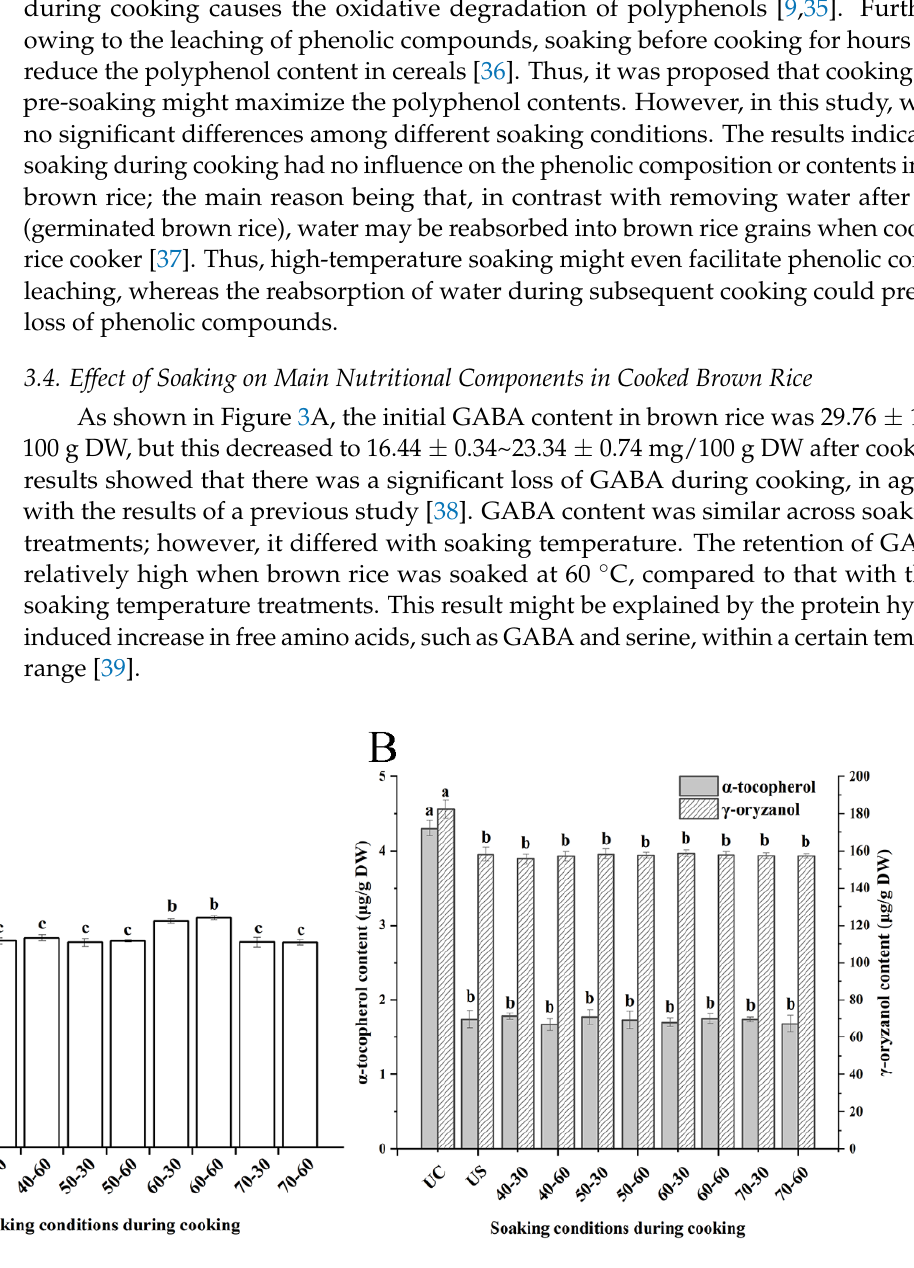
Figure 3. The GABA ( A ), γ -oryzanol and α -tocopherol ( B ) contents of uncooked brown rice and cooked brown rice under different soaking conditions. Abbreviation was listed: UC (uncooked brown rice), US (unsoaked brown rice); soaking conditions such as “40-30” respected soaking at 40 °C for 30 min. Results with different lowercase letters are significantly different ( p < 0.05).